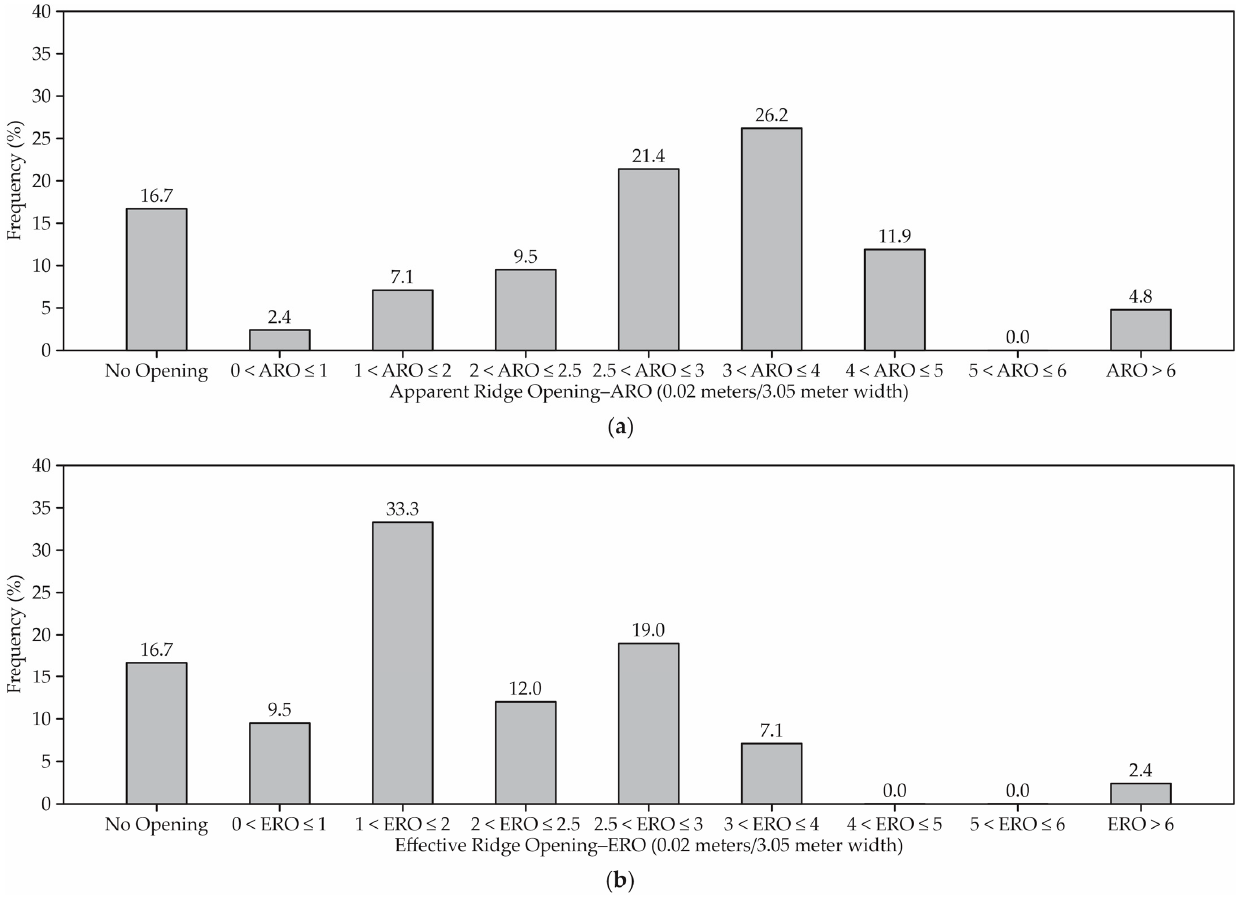
Figure 5. Ridge opening-to-barn width ratio for compost-bedded pack barns: ( a ) apparent ridge opening compost barns—0.02 meter/3.05 meter width and ( b ) effective ridge opening compost barns—0.02 meter/3.05 meter width.